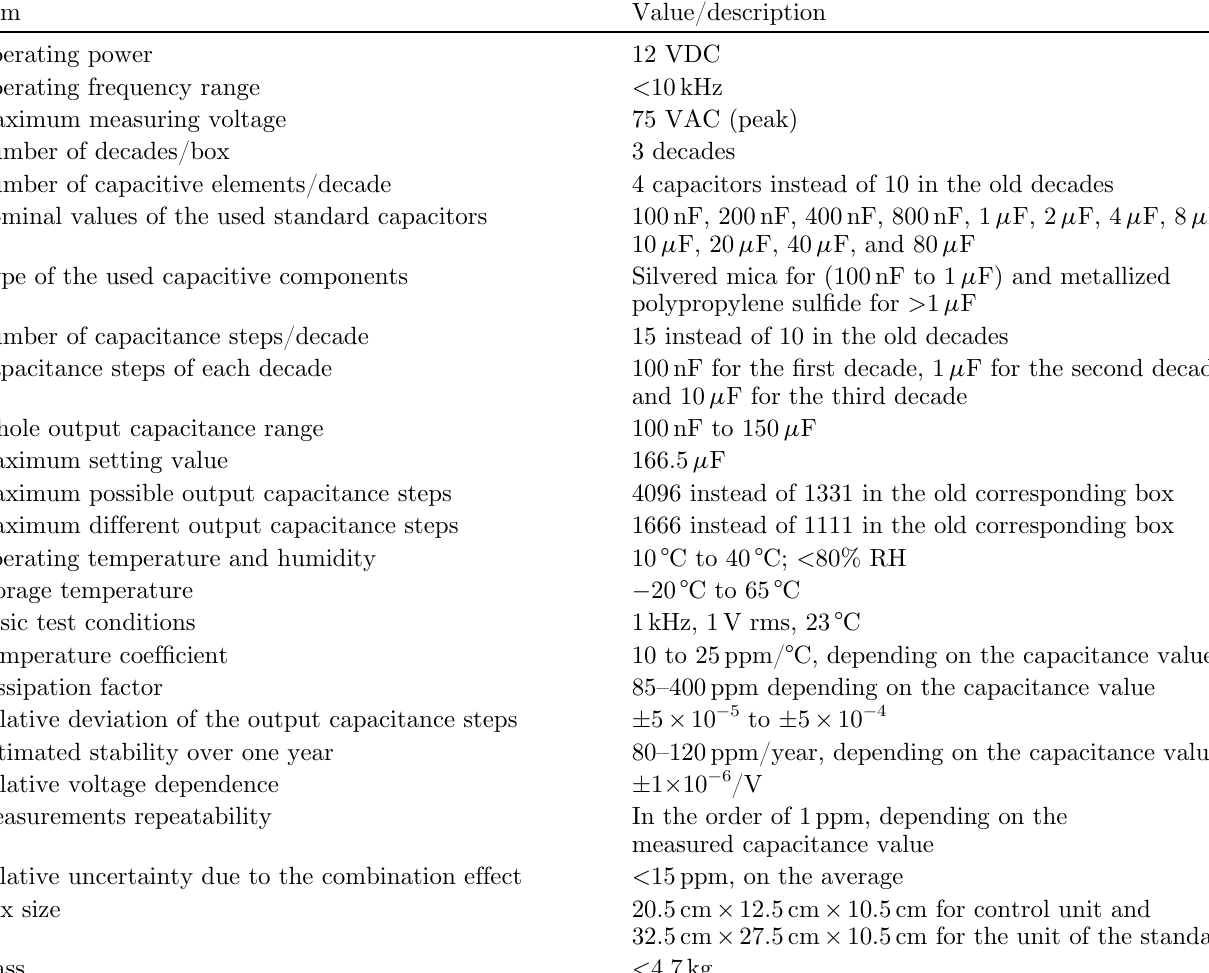
Table 3. Main speci fi cations of the new fabricated capacitance box.